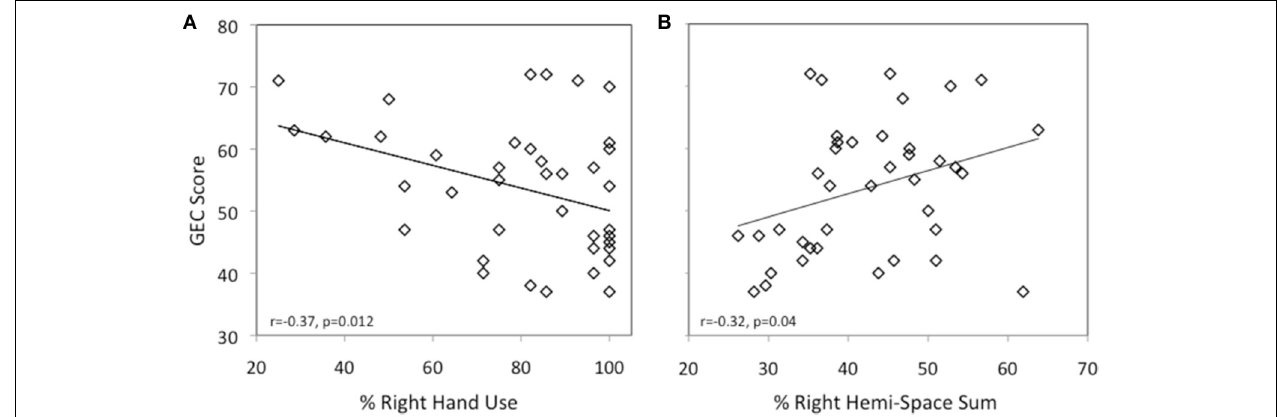
FIGURE 3 | (A) The graph depicts the relationship between percent right hand use in the grasp-to-place task and the standard score obtained on the General Executive Composite of the BRIEF for all children (younger and older). A significant negative correlation was observed ( r = − 0 . 368, p = 0 . 019), indicating that the more the right hand was used for grasping, the lower (better) the overarching EF score. (B) The graph depicts the relationship